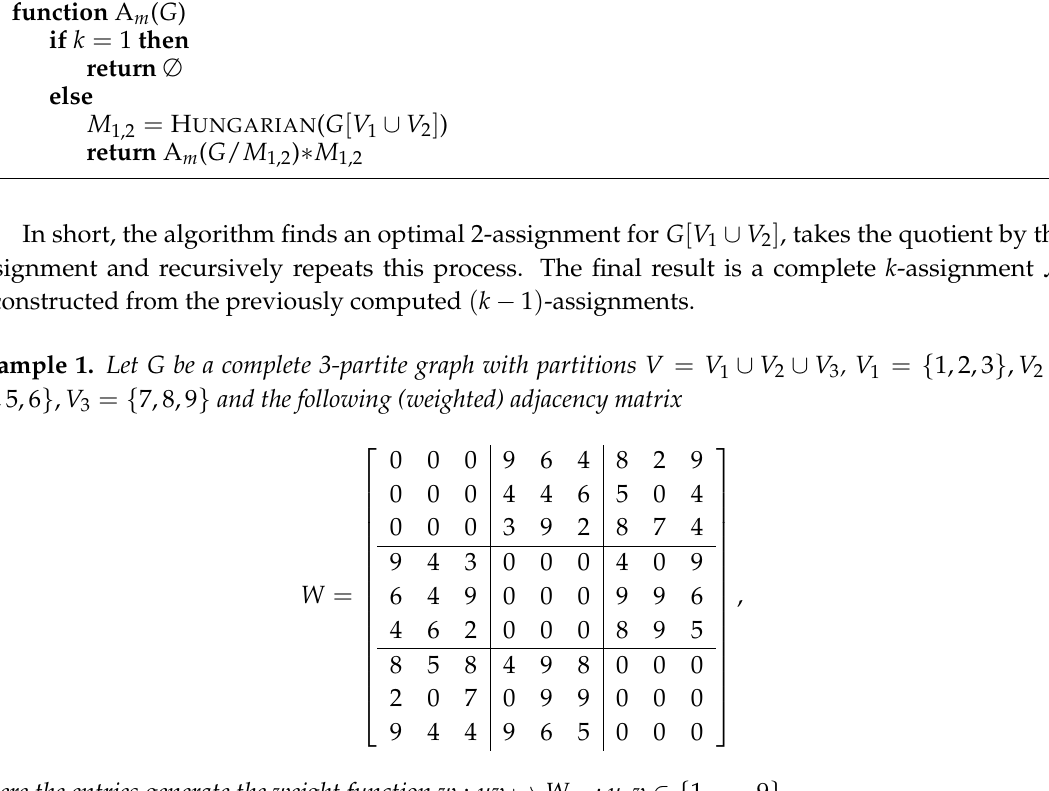
Algorithm 1 , A m . The following algorithm, which we denote by A m , for finding near optimal solution for the minimal k -assignment problem of k -partite graph G has been proposed in [28]. Algorithm 1 [28].